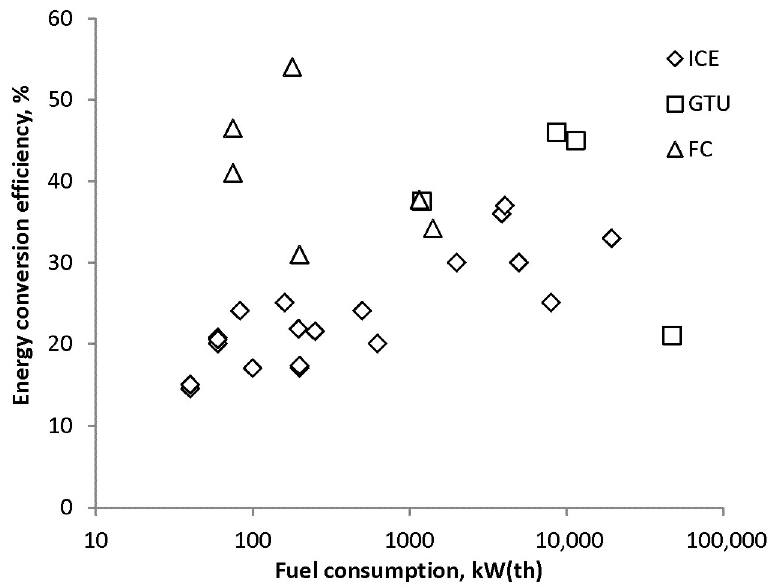
Figure 2. Dependency of thermal efficiency of a gasification-based plant on its fuel consumption capacity according to [38–64] (ICE—internal combustion engine; GTU—gas turbine; FC—fuel cell).